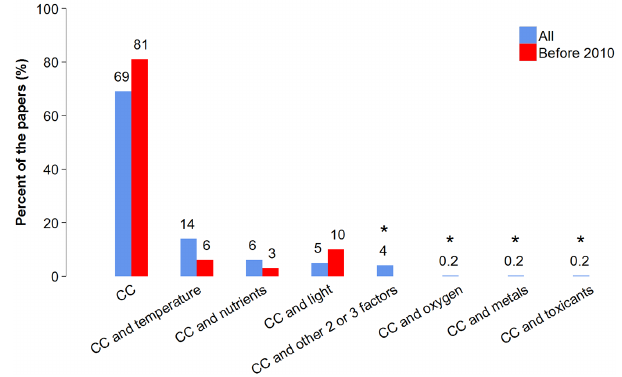
Figure 3. Taxonomic coverage of the papers from which data have been included in the OA-ICC data compilation, compared to those archived prior to 2010. Categories marked with ∗ were not present in Nisumaa et al. (2010).